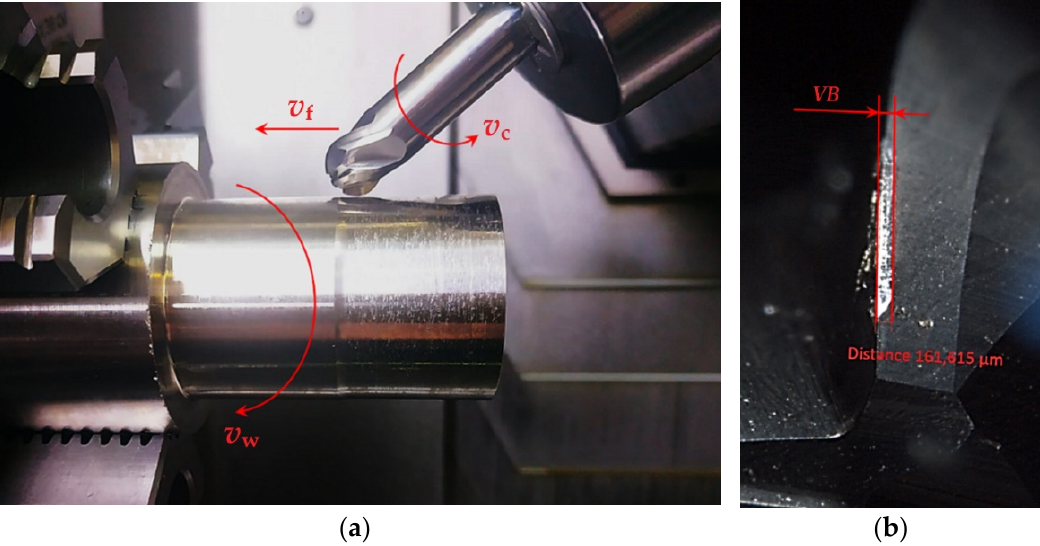
Figure 3. A strategy for performing a milling/turning test on ball end mills to evaluate cutting properties ( a ) and tool wear on the flank face criterion, VB ( b ).